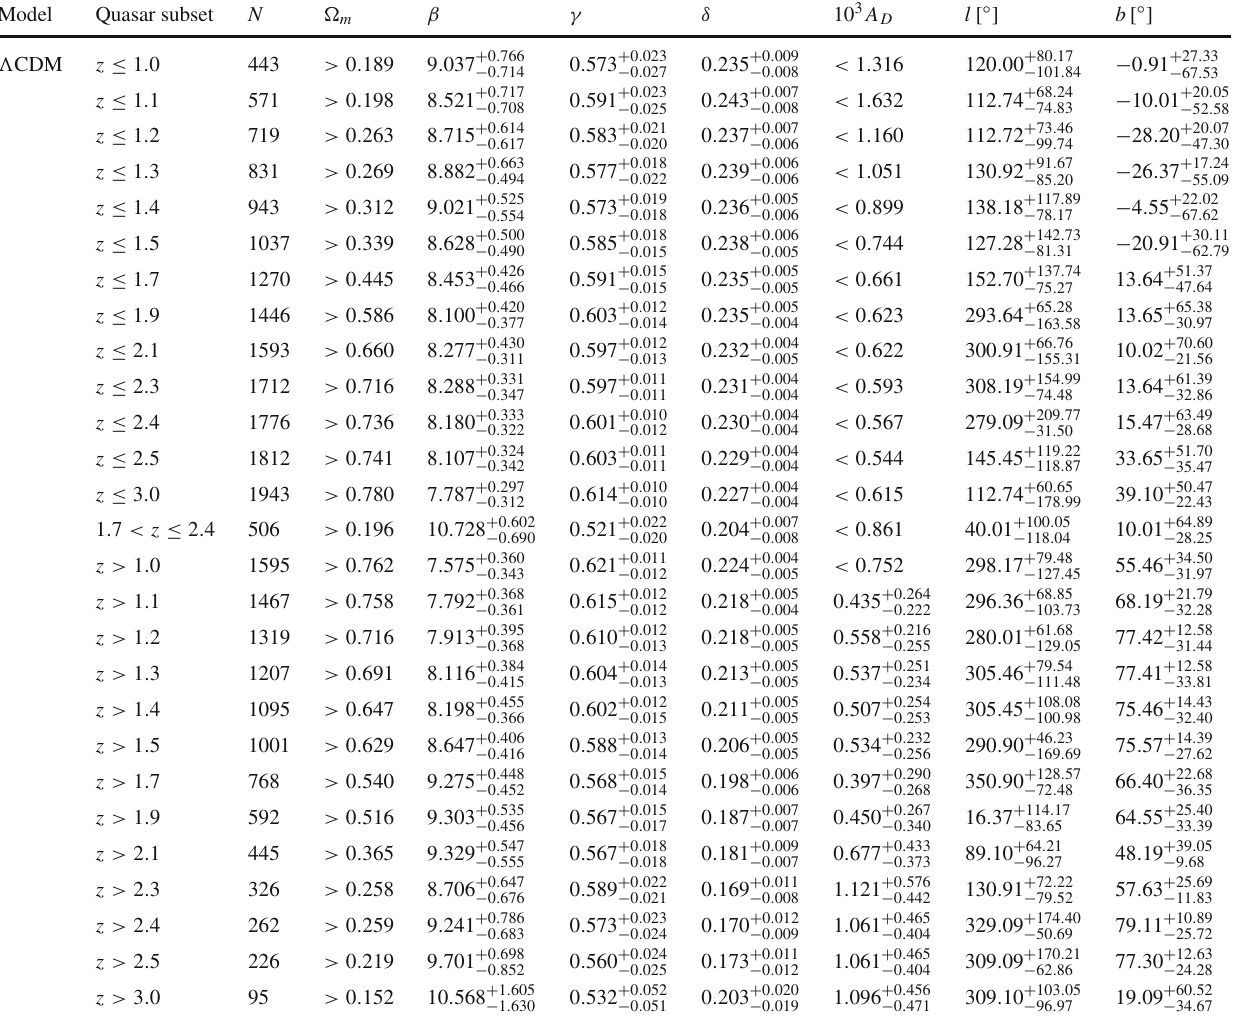
Table 1 The 68% confidence level constraints of the parameters in the dipole-modulated (cid:2) CDM model with different cutting redshifts. If the upper or lower limit of a parameter exists, we show the 95% confidence level of the